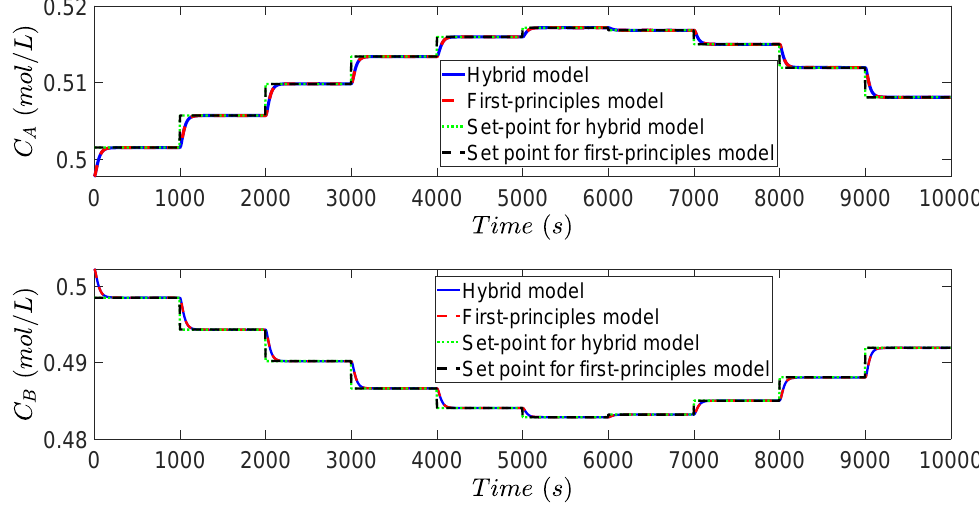
Figure 5. Evolution of the concentration of A and B for the CSTR case study under the proposed real-time optimization (RTO) and